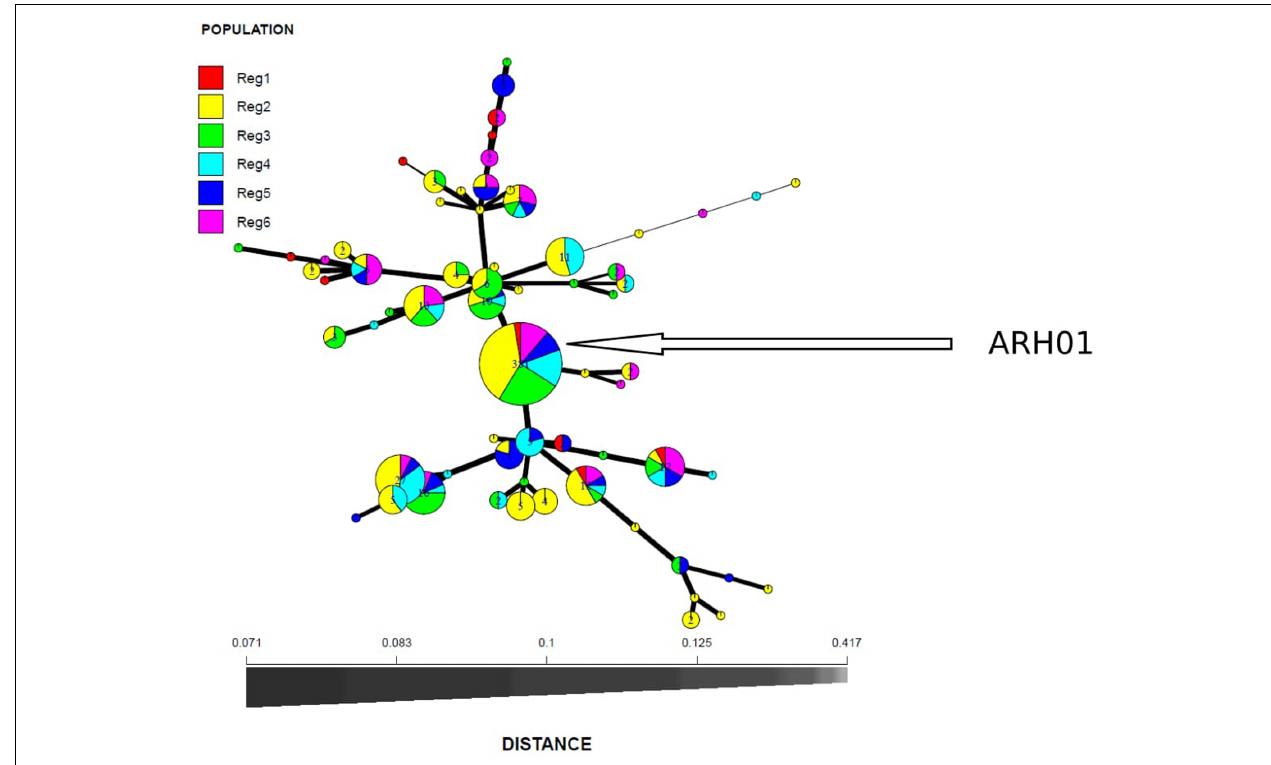
FIGURE 3 | Minimum spanning network based on Bruvo genetic distances representing 66 MLGs observed in six A. rabiei populations from Australia. Node colors represent population membership proportional to the pie size. Node sizes are relatively scaled to logl.75n, where n is the number of samples in the nodes to reduce node overlap. Edge thickness (lines) represent minimum genetic distance between haplotype.